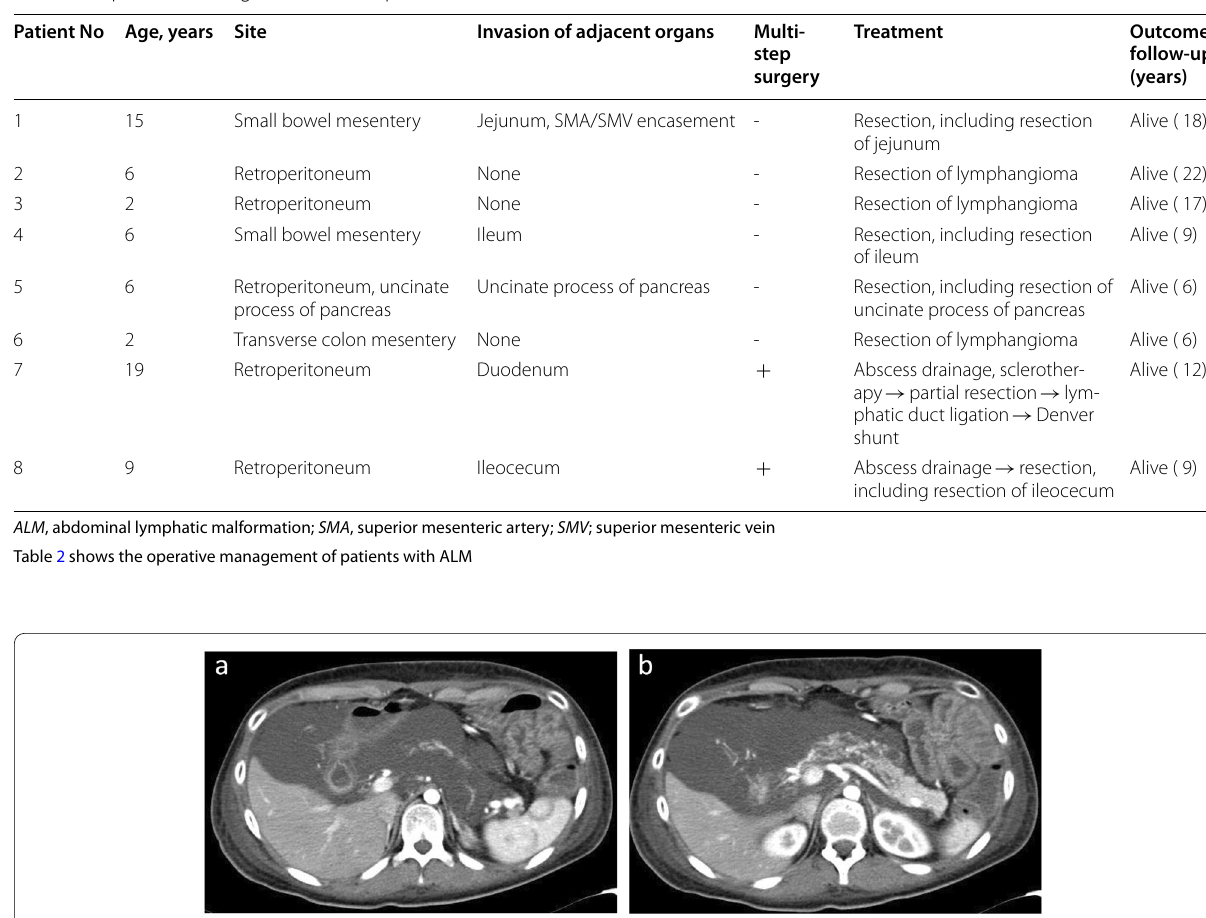
Table 2 Operative management of ALM patients